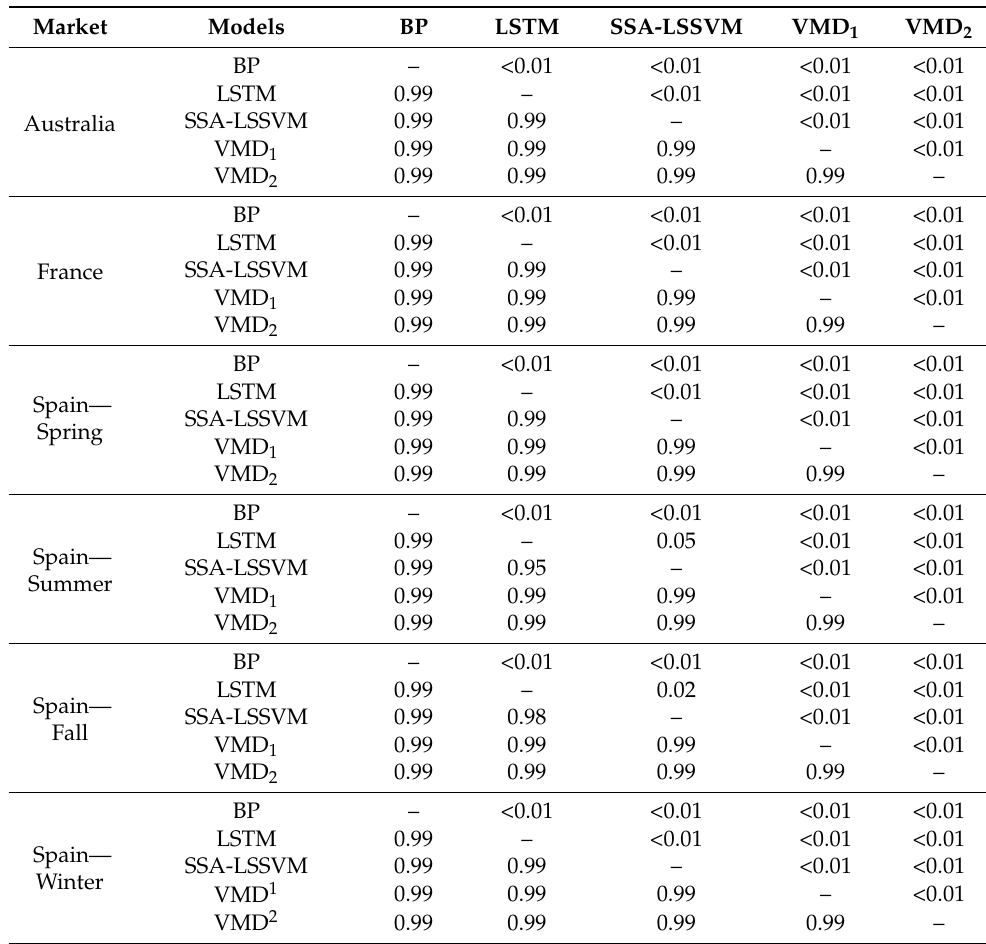
Table 4. p -values of the Diebold and Mariano